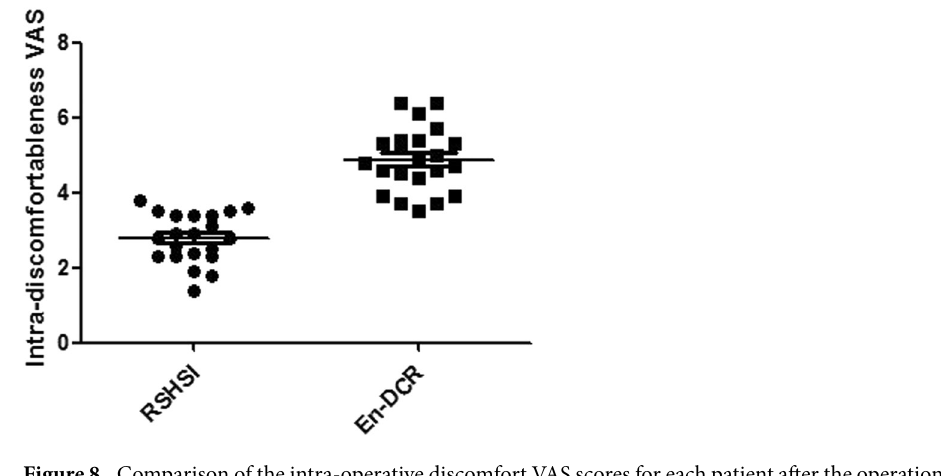
Figure 8. Comparison of the intra-operative discomfort VAS scores for each patient after the operation. (n = NLDO patients, respectively n 1 = 21, n 2 = 22, P =